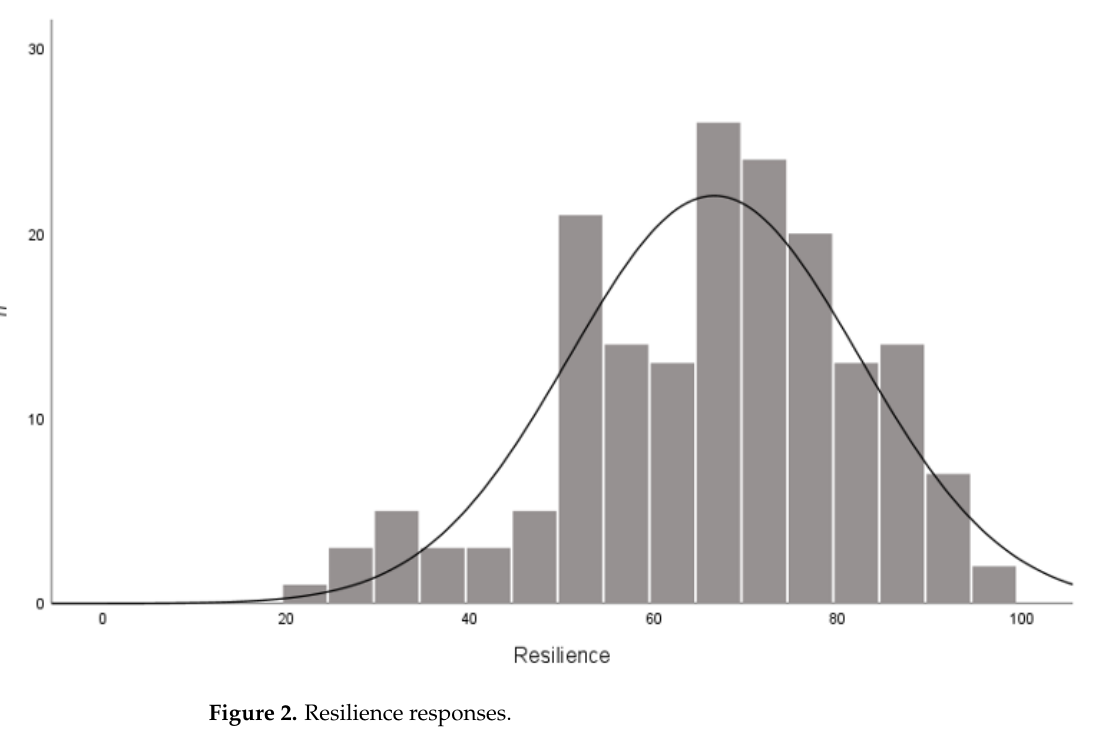
Figure 2. Resilience responses.